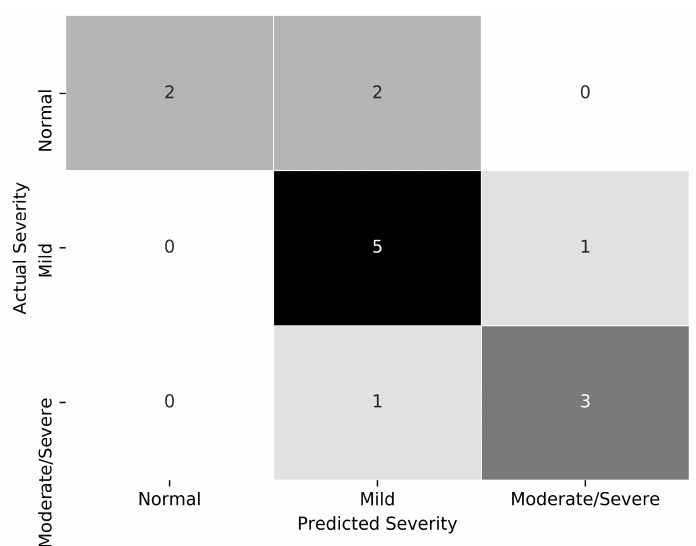
Figure 8. Confusion matrix for OSA severity classification from multiple nights, including in-clinic and in-home studies, with reference